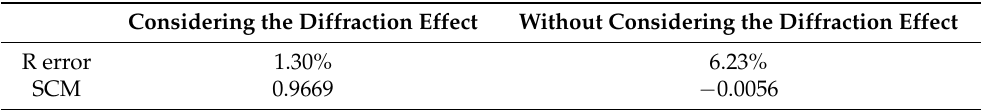
Table 5. Calculation results of spectral accuracy evaluation criteria. Considering the Diffraction